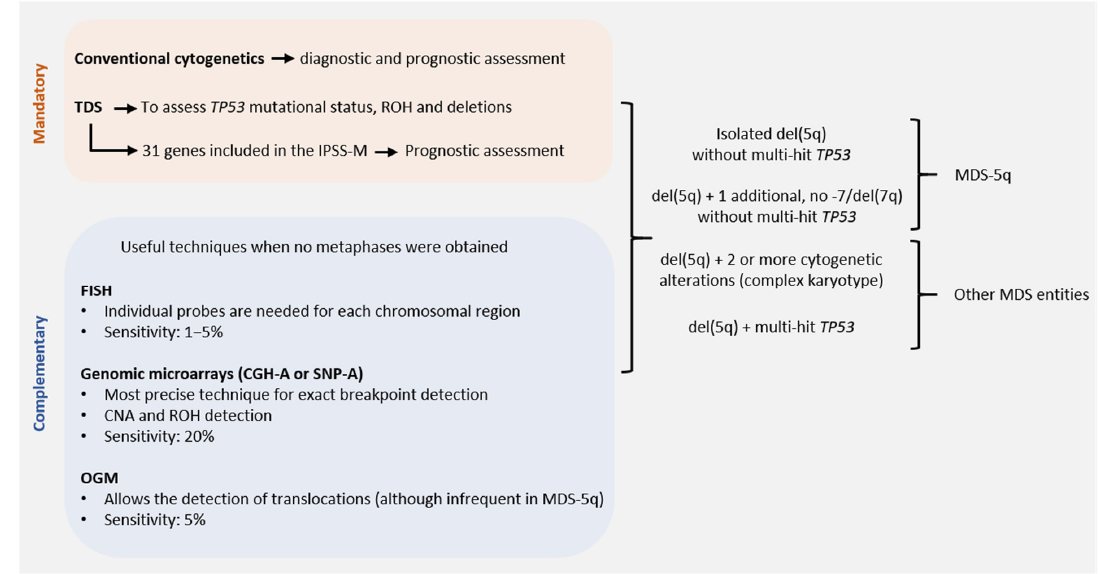
Figure 2. Genetic studies of MDS ‐ 5q according to the new diagnostic and prognostic guidelines: techniques available for correct diagnostic and prognostic assessment of MDS ‐ 5q according to the criteria of the next World Health Organization (WHO) classification, the proposal of the International Consensus Classification (ICC) and the Molecular International Prognosis Scoring System (IPSS ‐ M). Abbreviations: CGH ‐ A, comparative genomic hybridization; CNA, copy number altera ‐ tion; FISH, fluorescence in situ hybridization; OGM, optical genome mapping; ROH, region of ho ‐ mozygosity; SNP ‐ A, single nucleotide polymorphism array; TDS, targeted gene sequencing (assum ‐